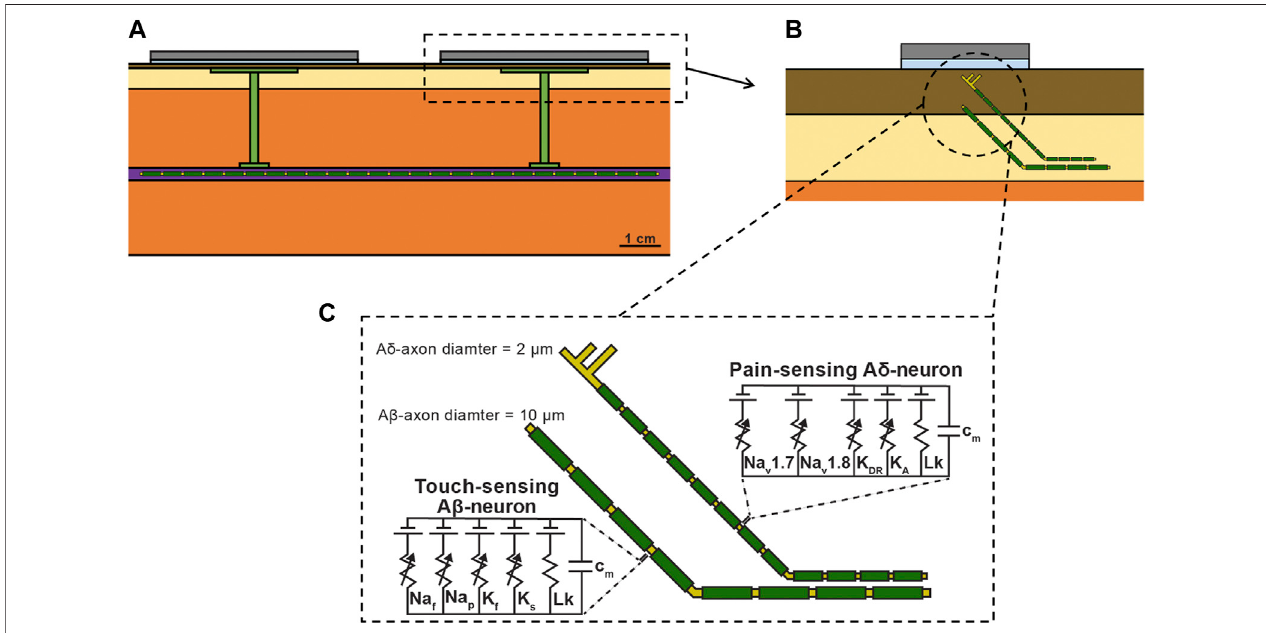
FIGURE3|(A) FullFEMmodelusedinthebiophysicalstudy.The1 k Ω resistorbetweenthetwocollectorsinthesimpli fi edFEMmodelwasreplacedwiththevagus nerve,Injectrode connections down to thevagus nerve,and Injectrode interfaces withthe vagus nerve. The vagus nerve was populated with axons. (B) Zoomed viewof dotted box in (a) showing the skin populated with cutaneous fi bers. (C) Biophysical equivalent circuit model of cutaneous A β and A δ neural fi